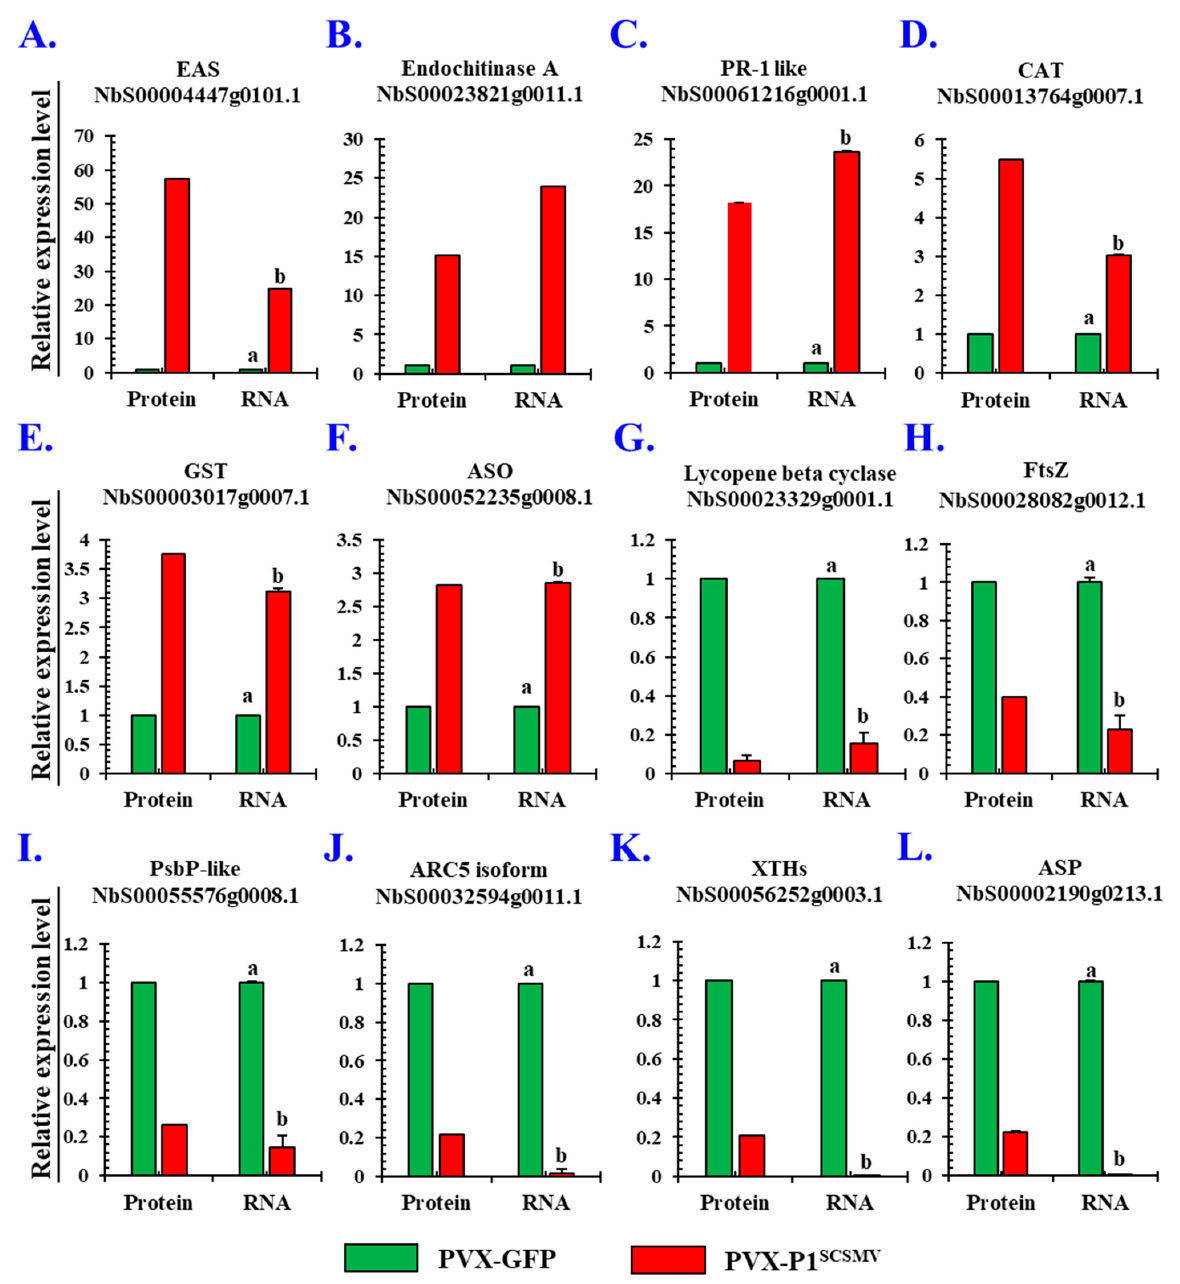
Figure 5. Validation of the relative expression levels of partial DAPs by qRT-PCR in Nicotiana benthamiana. Six upregulated and six downregulated DAPs were selected, and their corresponding mRNA expression levels were quantified by qRT-PCR analyses (left panel: protein expression level; right panel: RNA relative expression level). ( A ) 5-Epi-aristolochene synthase-like (EAS). ( B ) Endochitinase A (ECA). ( C ) Pathogenesis-related protein 1 like (PR-1 like). ( D ) Catalase (CAT). ( E ) Glutathione S-transferase U9-like (GST). ( F ) L-ascorbate oxidase-like isoform X2. ( G ) Lycopene beta cyclase, chloroplastic. ( H ) Cell division protein FtsZ homologue 1 (FtsZ). ( I ) PsbP domain-containing protein 5 (PsbP-like). ( J ) Dynamin-like protein ARC5 isoform (ARC5i). ( K ) Xyloglucan endotransglucosylase (XTHs). ( L ) Aspartic proteinase (ASP). Columns filled with green represent PVX-GFP-infected plants, whereas the red-filled columns refer to PVX-P1 SCSMV -infected plants. The processed data were statistically analysed using SPSS software (version 22.0, IBM), and comparison analyses were performed by one-way analysis of variance (ANOVA). Different letters (a & b) mean significant difference between these two